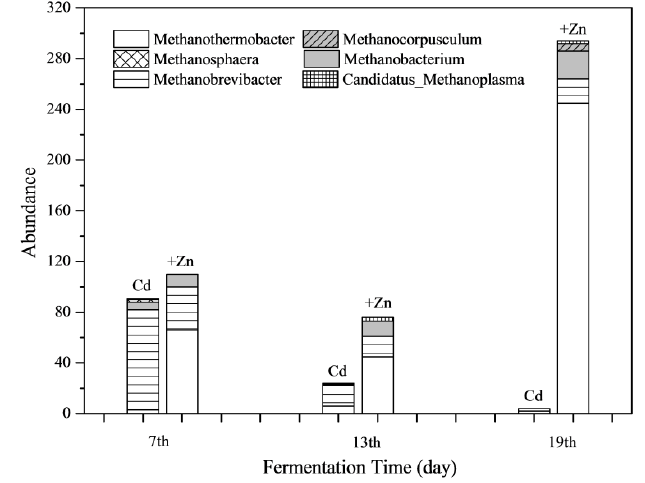
Figure 9. Impact of Cd and Cd+Zn addition on methanogen community composition during the fermentation.